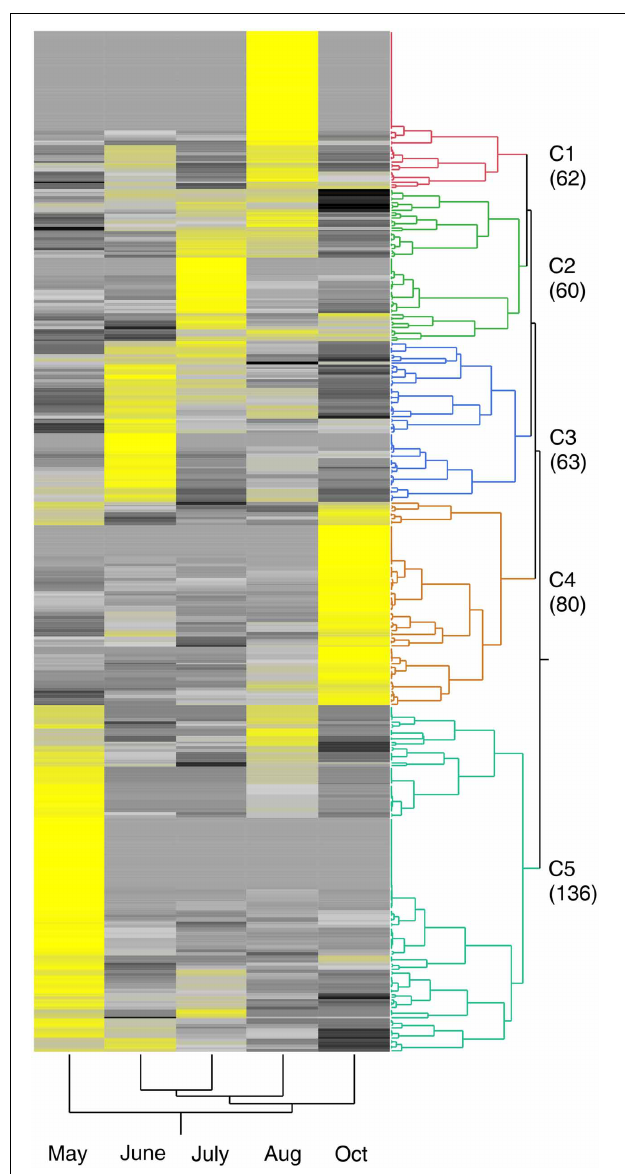
FIGURE 2 | Two-Way clustered expression profile map of genes of switchgrass nutrient transporters present in crown and rhizome tissues of field grown cv Summer plants harvested at different times during the growing season. Yellow indicates high abundance, gray is intermediate and black is low or negligible abundance. The clusters are labeled as C1 through C5. The numbers in parentheses under each cluster indicate the total number of transporter identified within each cluster. The appropriate SRA identification numbers for these individual NGS files